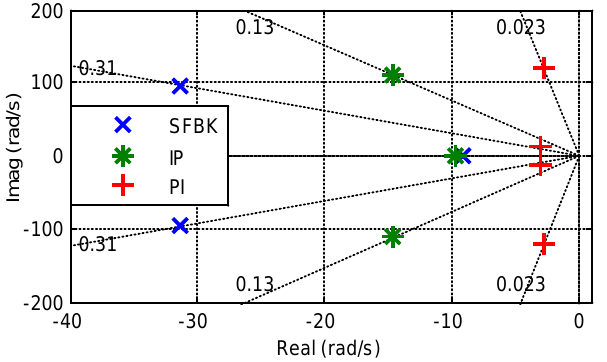
Figure 10. The dominant poles for all controllers.